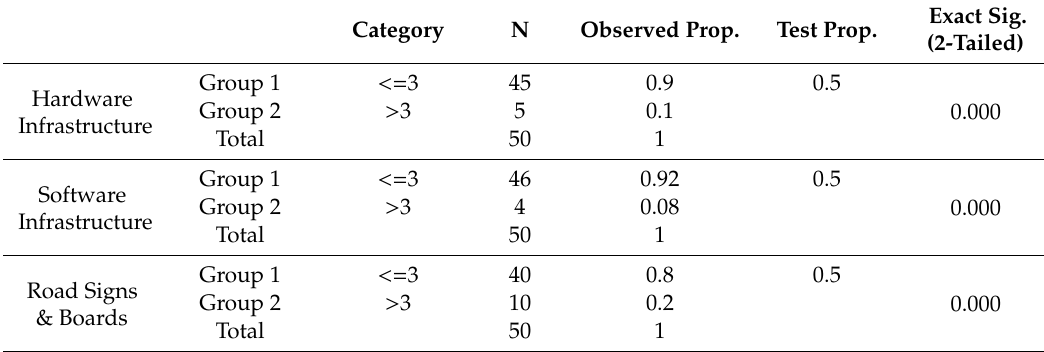
Table 12. Binomial test (Statistics) for critical investments required to facilitate AV. Category Observed Prop.